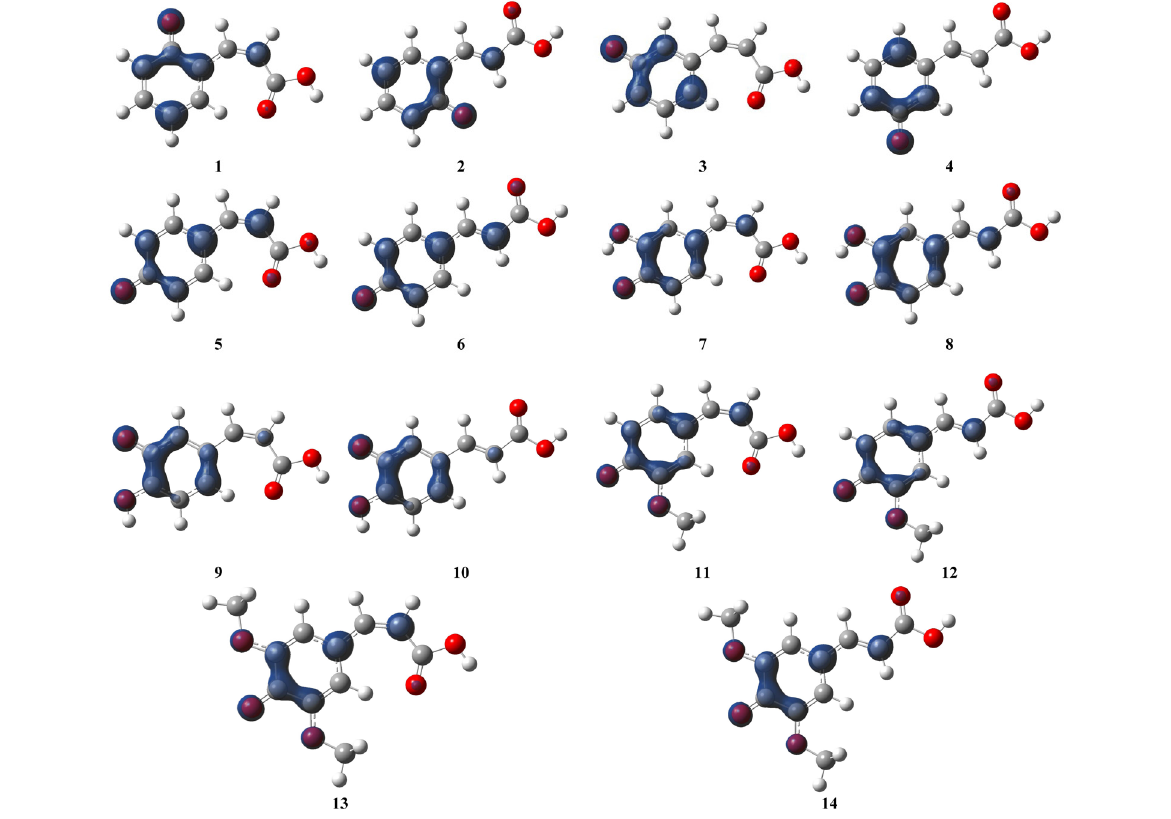
Figure 5: The uB3LYP/6-311++G(2d,2p) total SOMO for radicals of (1) c-o- CA 5`-O, (2) t-o- CA 1`-O, (3) c-m- CA 4`-O, (4) t-m- CA 2`-O, (5) c-p- CA 3`- O, (6) t-p- CA 3`-O, (7) c -KA 3`-O, (8) c -KA 4`-O, (9) t -KA 3`-O, (10) t -KA 4`-O, (11) c -FA 3`-O, (12) t -FA 3`-O, (13) c- SA 3`-O, (14) t- SA 3`-O in vacuum. The calculations for canonical MOs were accomplished with isovalue